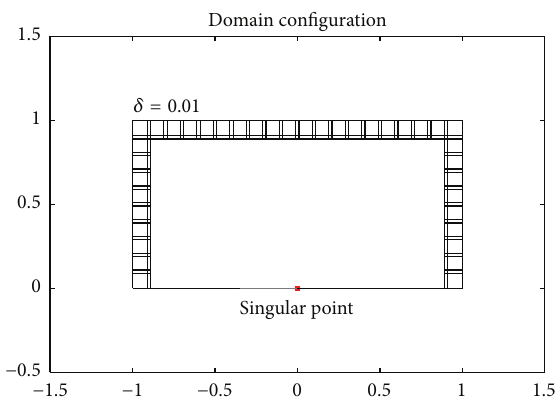
Figure 2: 39 overlapping patches, which consist of one large patch and 38 surrounding patches, cover the domain. Each patch is the support of corresponding partition of unity function. The overlapping regions are pictured as strip that has width 2𝛿